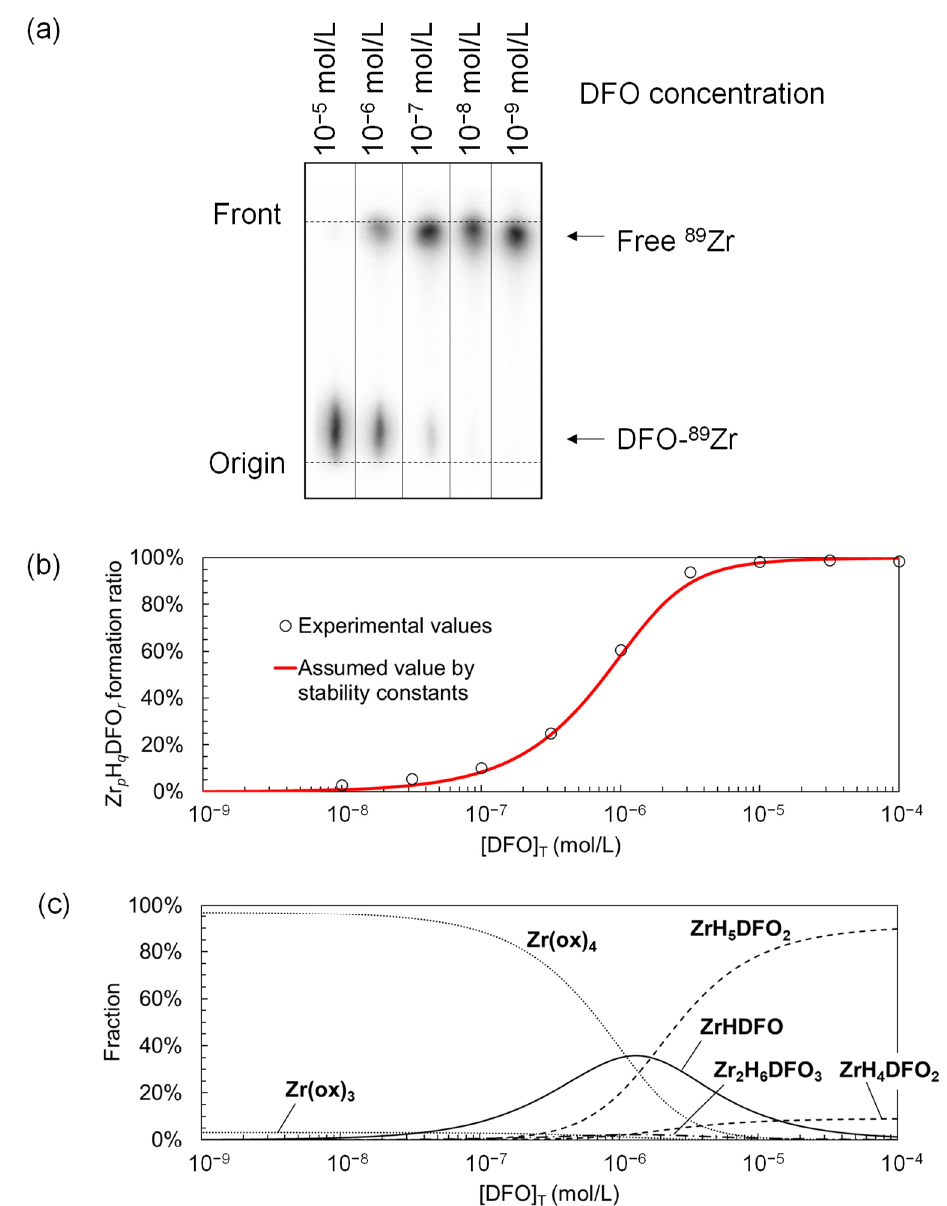
Figure 4. Results of the competition titration. ( a ) ITLC images of the competitive 89 Zr titration of DFO (10 − 9 –10 –5 mol/L) vs oxalate (0.1 mol/L). Free 89 Zr was distributed at R f = 0.8–1.0; 89 Zr-DFO at R f = 0.2–0.3. ( b ) Titration curves of Zr p H q DFO r formation ratio against the DFO concentration. The formation ratio is shown as approximately equal to the radioactivity of 89 Zr-DFO per total radioactivity of 89 Zr. The open circles show experimental values of the competitive titration, and the red solid line indicates the theoretical curve assumed from the Equation (2) using the calculated stability constants. ( c ) Speciation curves of the Zr p H q DFO r , Zr(OH) s , and Zr(ox) t species in the system of DFO (10 –9 –10 –4 mol/L) oxalate (0.1 mol/L) at pH 7.0. Calculated from the stability constants obtained in this study.